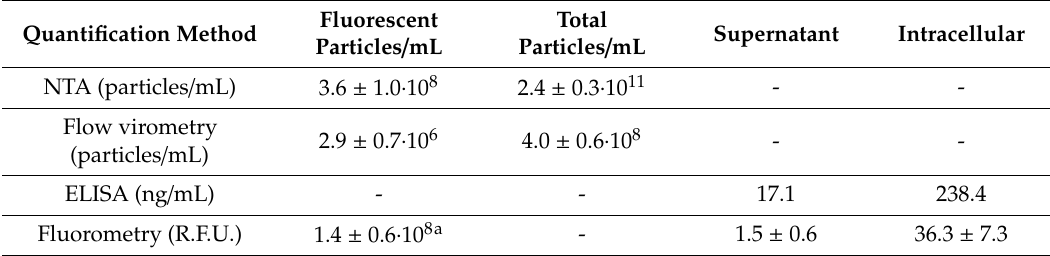
Table 1. Gag-eGFP production in shake flasks at 72 hpt using di ff erent quantification